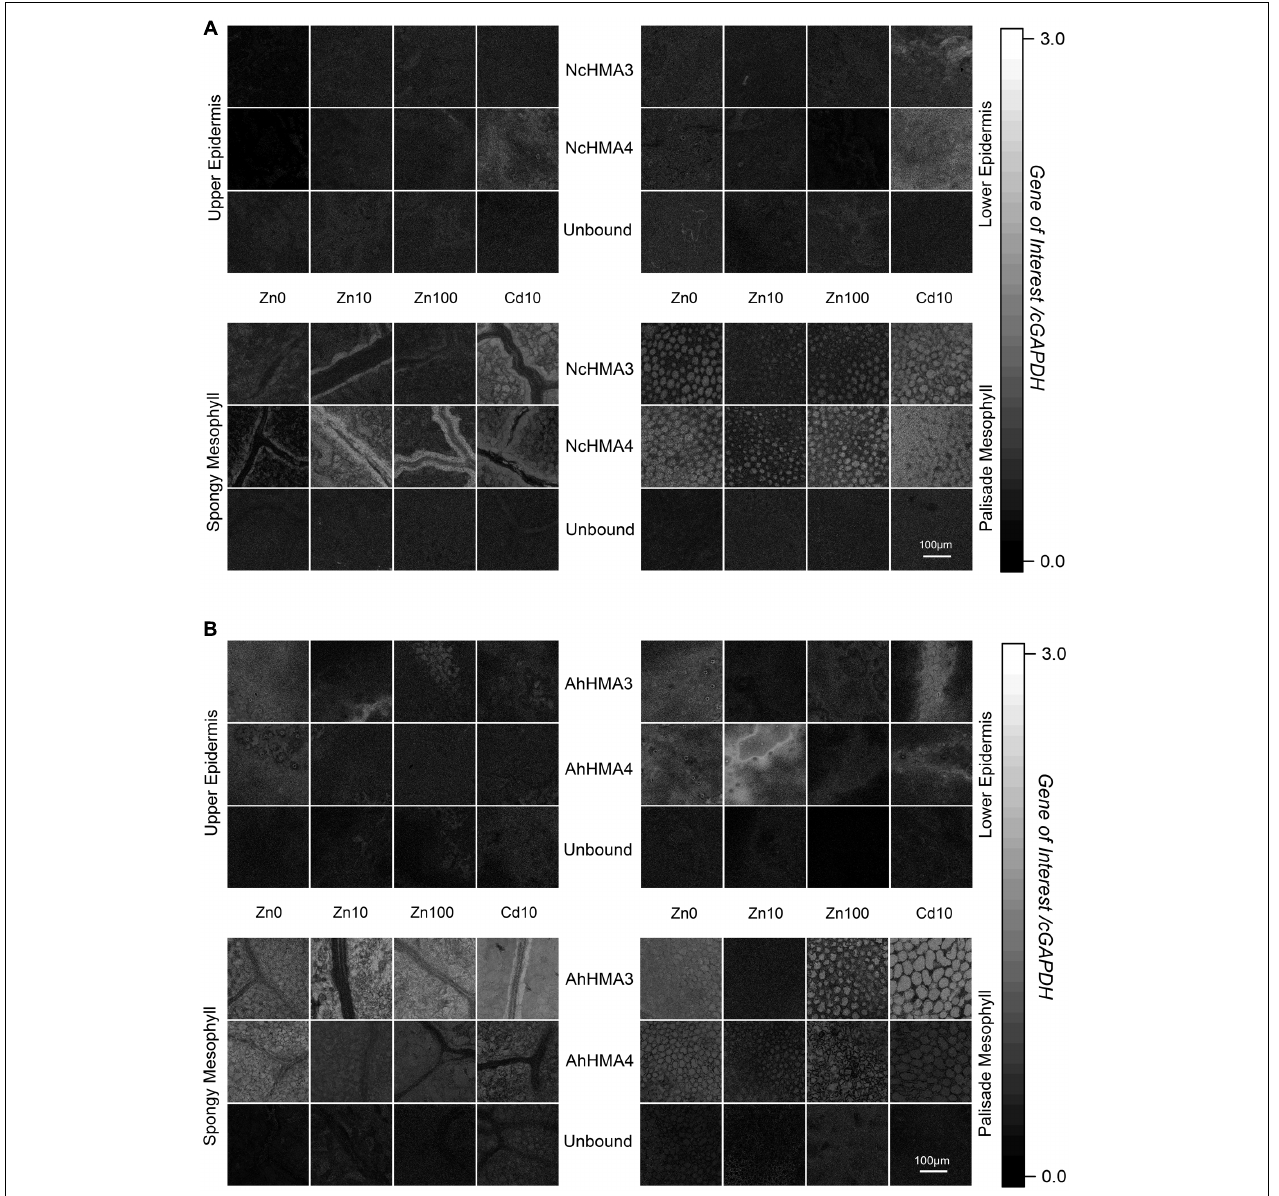
FIGURE 5 | Cellular expression regulation of HMA3 and HMA4 in N. caerulescens (A) and A. halleri (B) using QISH technique. Quantitative images showing the background-corrected concentration ratio of the transcripts of the genes of interest and cGAPDH probe fluorescence signals in a horizontal optical section through a mature leaf of respective plants grown on metal treatments (Zn 2 + and toxic Cd 2 + ). Scale bar = 100 µ m. Autofluorescence images of the same samples that are displayed in this figure are shown in Supplementary Figure S1 to display the cellular structures of the analyzed tissues. The figure is representative of four independent